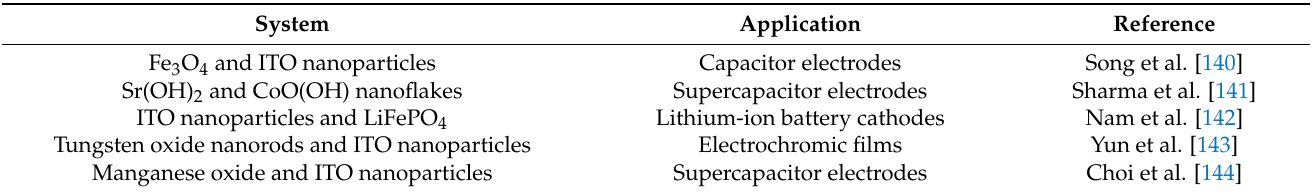
Table 4. Examples of LbL structures containing pseudocapacitive nanoparticles and their poten- tial